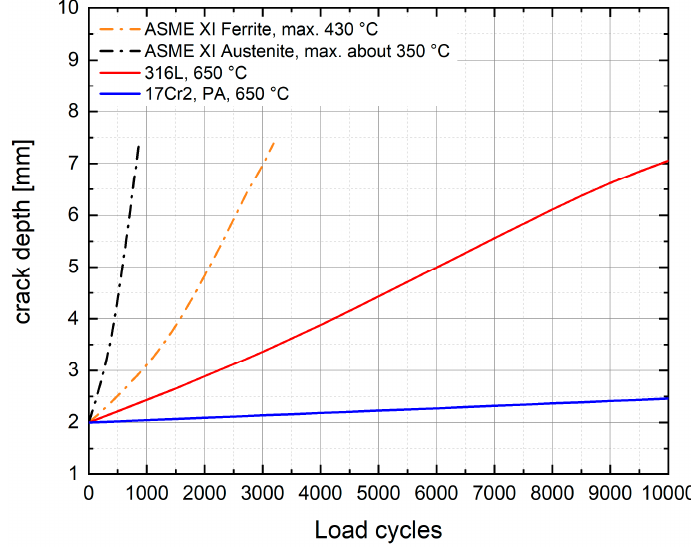
Figure 28. Calculated growth of a postulated 2 mm deep and 40 mm wide surface crack under cyclic loading (f = 20 Hz, R = 0.1, T = 650 °C) in various materials (ASME curves for comparison) at elevated temperatures.